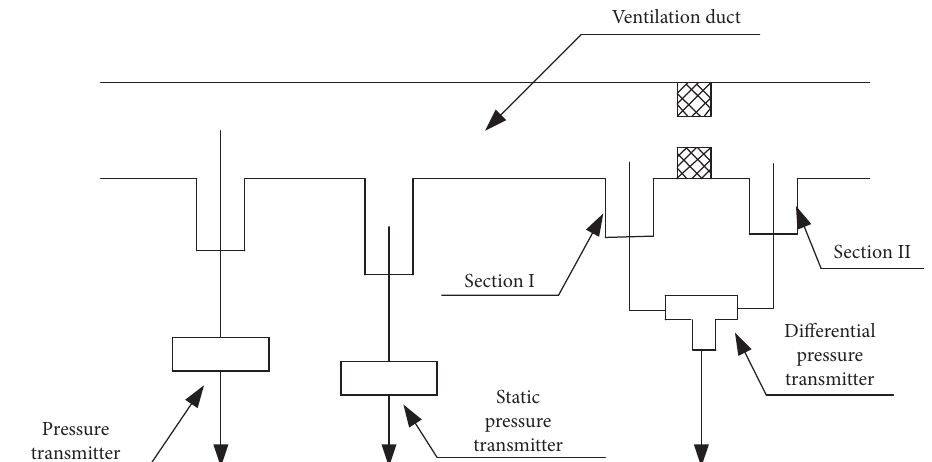
Figure 1: The structure of the blast capacity differential